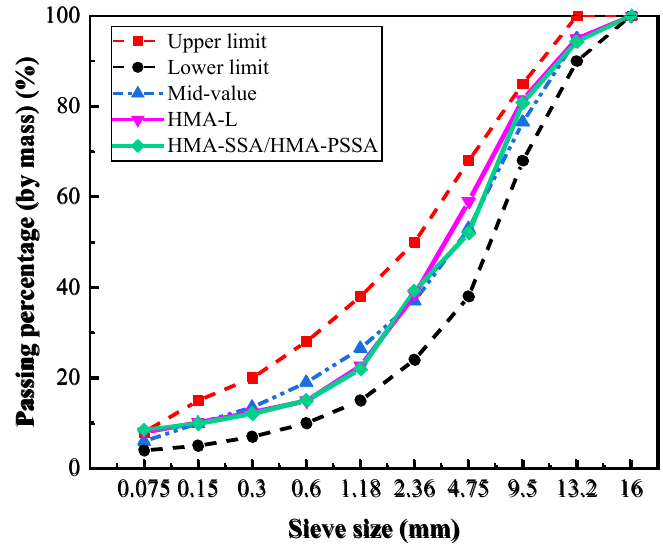
Figure 2. Gradation of three HMA.